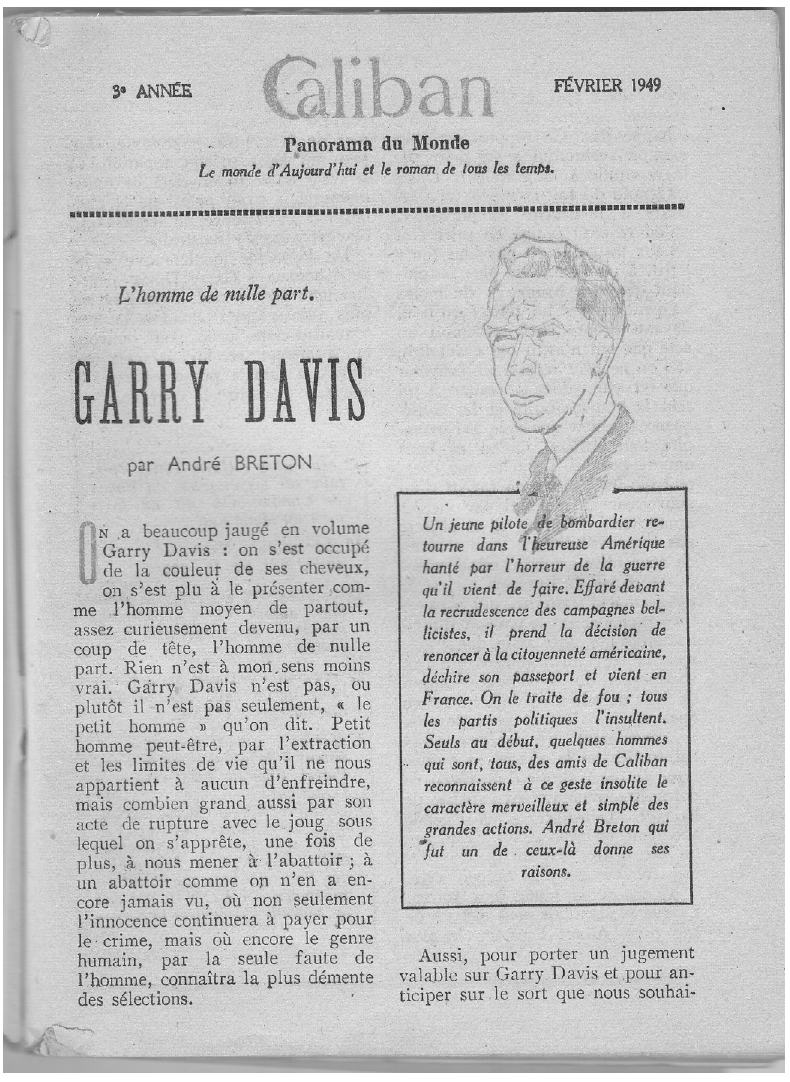
Fig. 2 André Breton, ‘L’homme de nulle part. Garry Davis’, Caliban , no. 24 (February